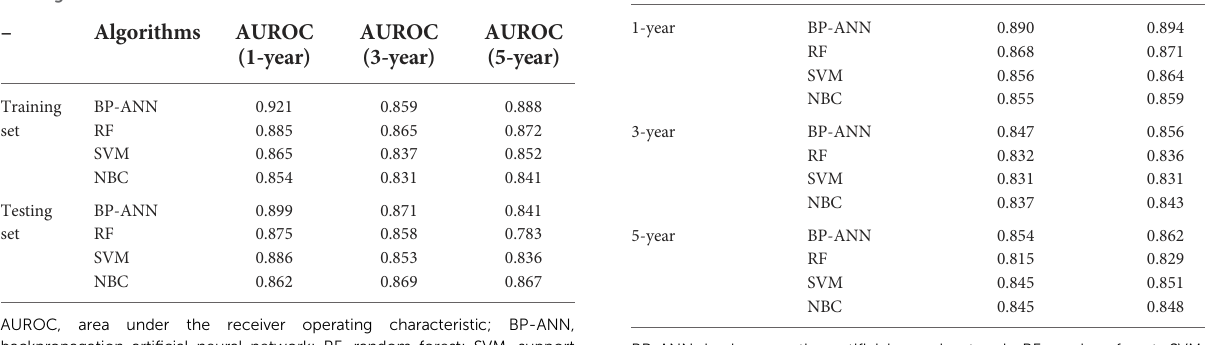
TABLE 3 Comparison of AUROCs among four ML-based models in the training set and test